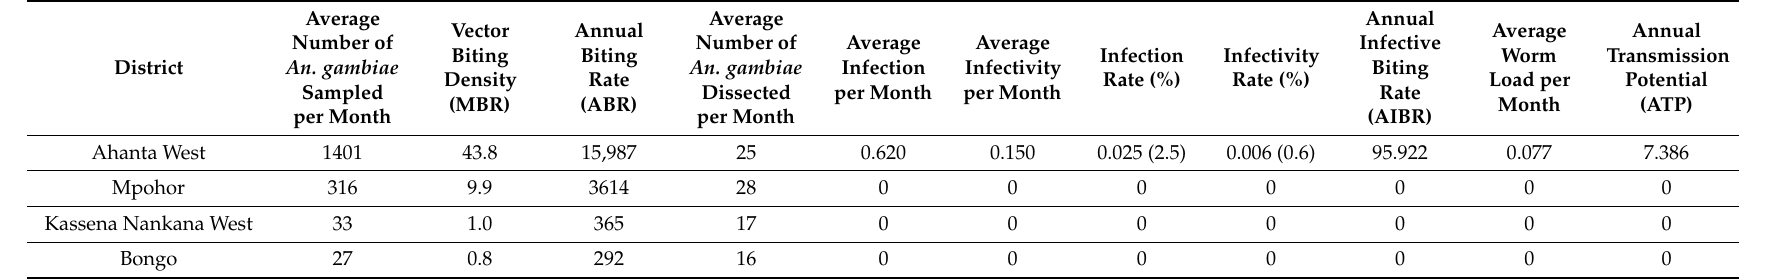
Table 4. Entomological indices showing relevant parameters for the estimation of the annual transmission potential (ATP).